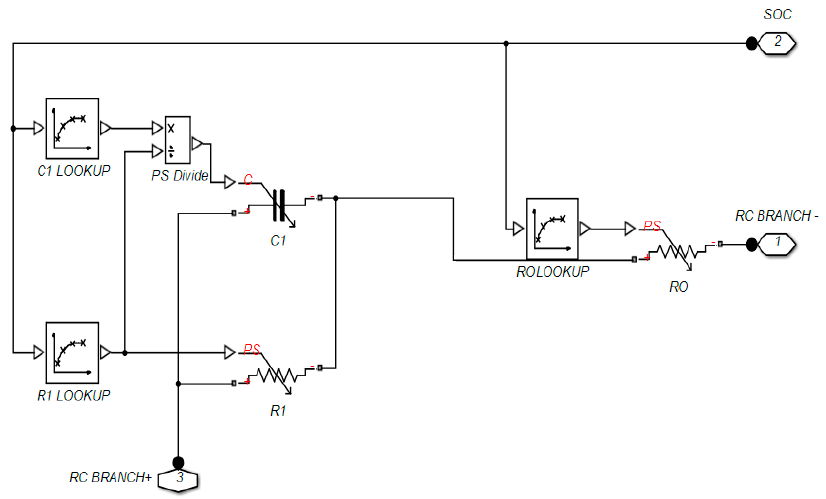
Figure 4. 1-RC equivalent circuit model of a single battery cell in Simscape [67].